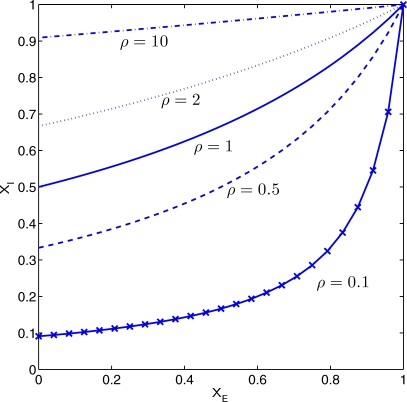
Fixed Point Loci for Networks with Tonic ActivityGeometrical loci of fixed points for the system with activity functions described in Equation 17. The locus depends on the parameter ratio ρ following Equation 18. Note the difference between the phase plane structure in this system and the phase plane presented in Figure 2. The difference is due to the different relationships between inhibitory and excitatory activity (compare Equations 17 and 8). (Wii = 0.3).